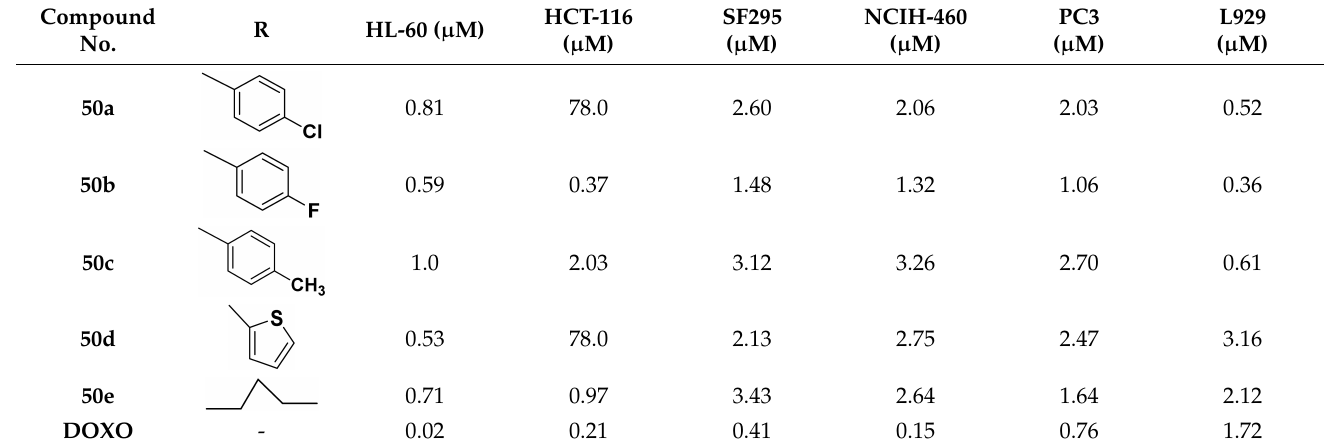
Table 44. In vitro cytotoxic activities of selenium based quinone triazole hybrid compounds 50 ( a – e ).